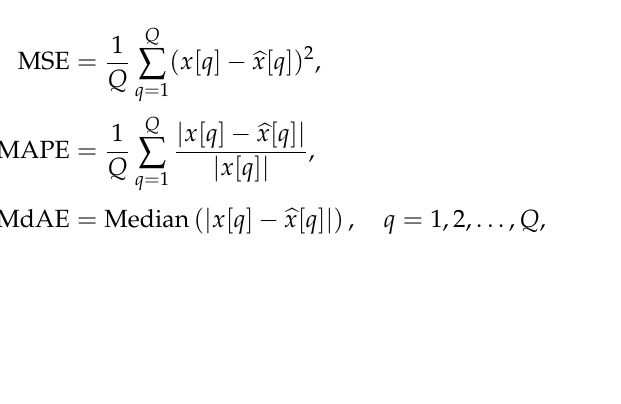
Figure 5. Ground scene prediction images for Stack 1 based on trimmed mean and median